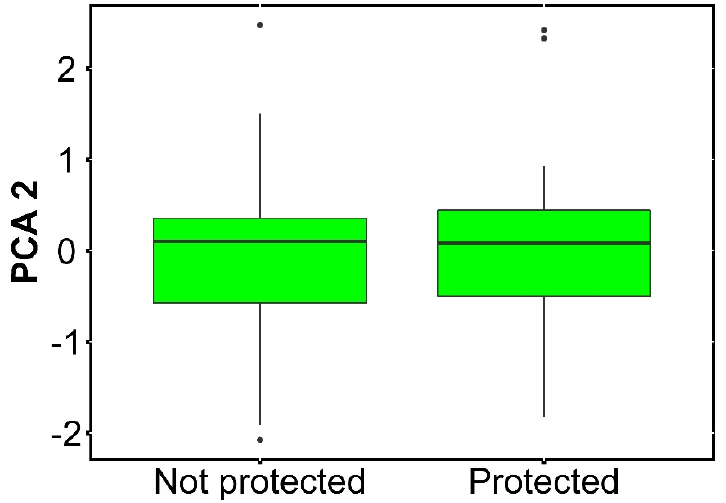
Figure 7. Boxplot of the second principal components (PCA 2) showed in Figure 5, grouping lakes by non ‐ protected ( n = 7) and protected areas ( n = 44). Dots represent outliers.